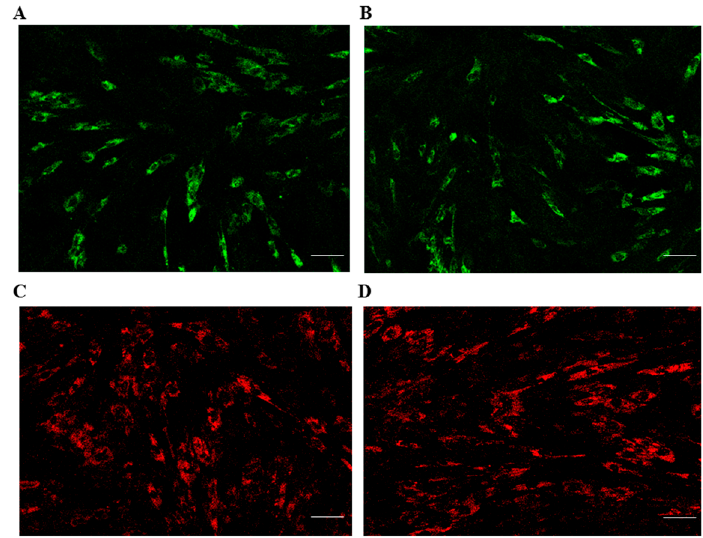
Figure 5. Mitochondrial and lysosomal activities of ALF-derived ADMSCs and normal ADMSCs at passage 5. ( A ) MitoTracker fluorescent staining of ALF-derived ADMSCs; ( B ) MitoTracker fluorescent staining of normal ADMSCs; ( C ) LysoTracker fluorescent staining of ALF-derived ADMSCs; ( D ) LysoTracker fluorescent staining of normal ADMSCs. Scale bars = 100 μ m.